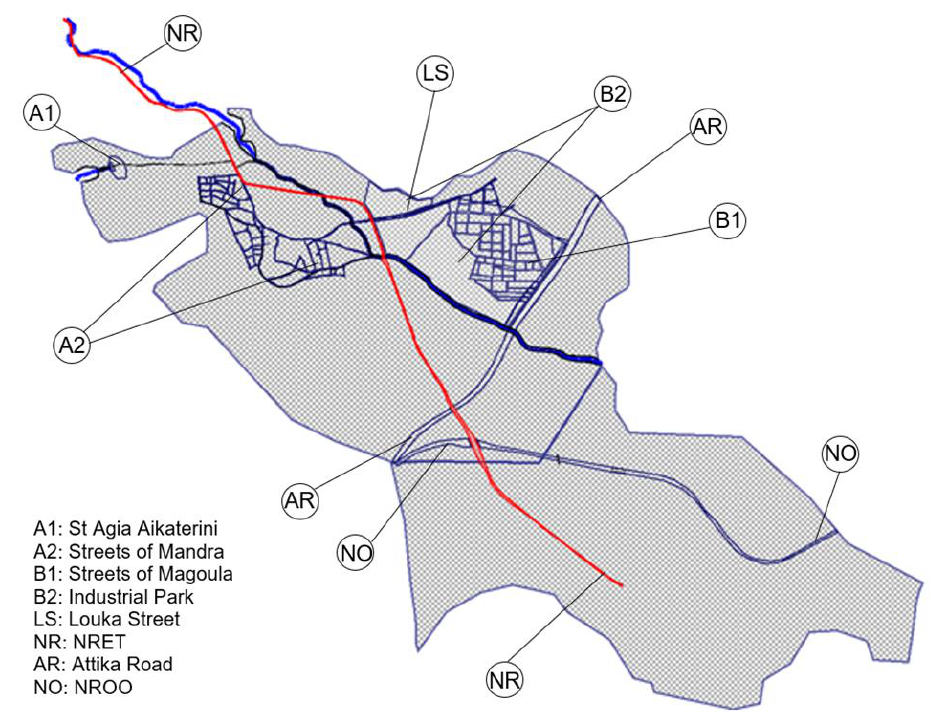
Figure 3. The numerical grid in the computational domain.